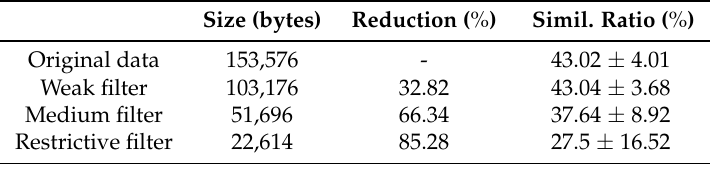
Table 2. Data reduction and similitude test for original DVS camera data (unfiltered), and different LDSI parameters.